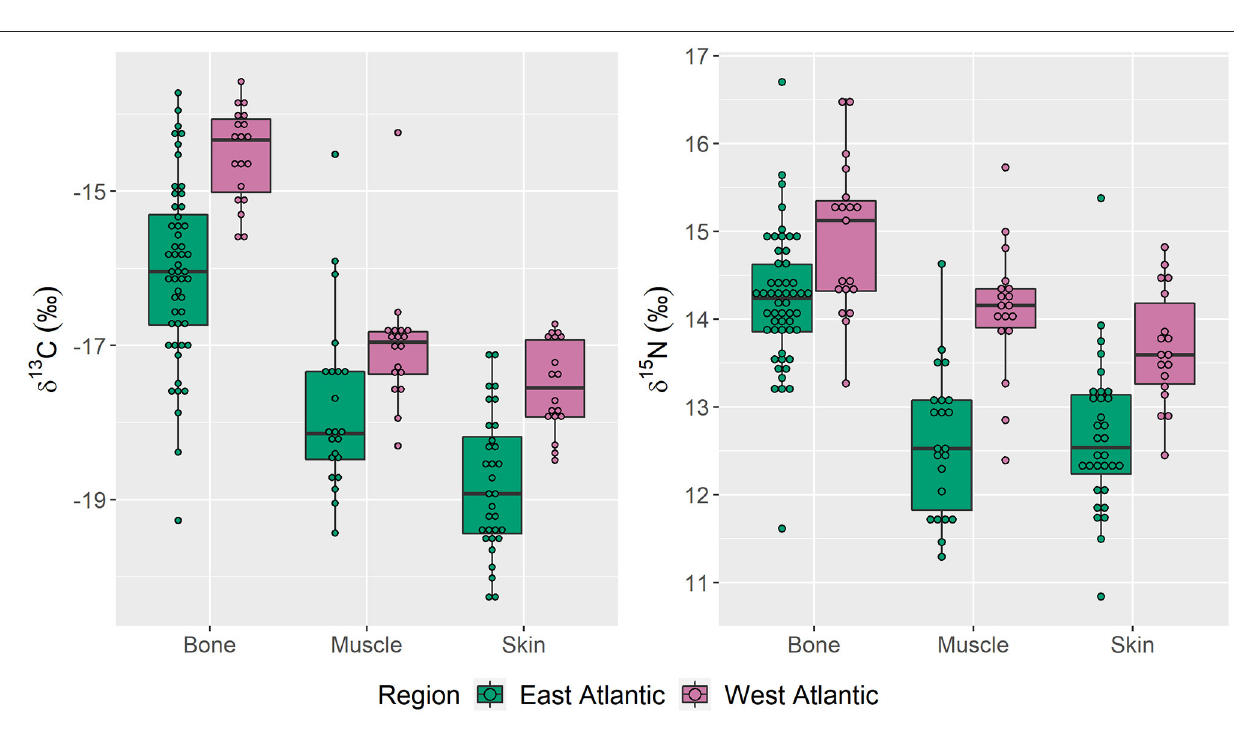
FIGURE 3 | δ 13 C and δ 15 N values from Sowerby’s beaked whale specimens of opportunity collected in the east ( n = 64) and west ( n = 38) Atlantic Ocean basin, 1980–2019. Boxes present median and interquartile range and whiskers represent 95% confidence intervals. demonstrated significant differences in median δ 13 C and δ 15 N values between east and west Atlantic samples in all three tissue types ( Table 1